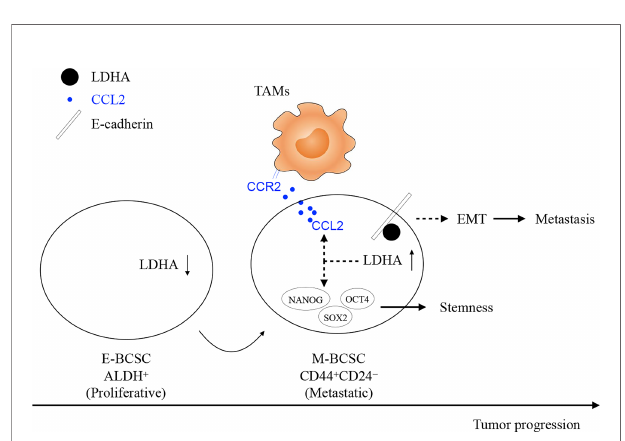
FIGURE 7 | The work model of glycolytic enzyme of LDHA not only maintains the stemness and heterogeneity of BCSCs but also facilitates the in fi ltration of TAMs to trigger immune escape of BCSCs. At the early stage of breast cancer, E-BCSCs promote tumor rapidly growth and recruit more CCR2-expressing monocytes/macrophages and then, LDHA reduces E- Cadherin expression and increases CCL2 secretion in M-BCSCs to facilitated tumor metastasis at the advanced stage of breast